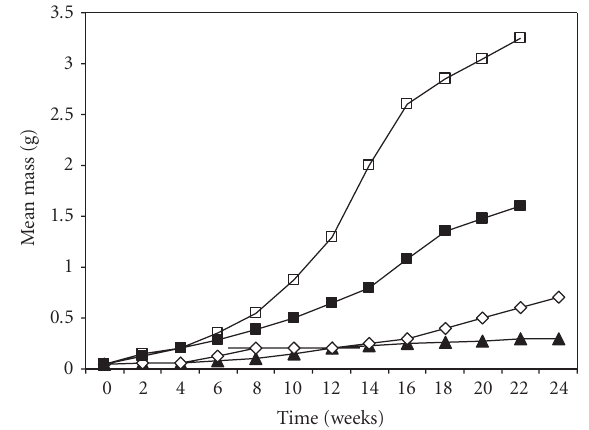
Figure 7: Typical earthworm growth curves obtained from periodic measurement of masses. Here Lumbricus terrestris was examined under constant temperature conditions ( (cid:2) − 20; (cid:3) − 15; ♦ − 10; (cid:5) − 5 ◦ C; adapted from